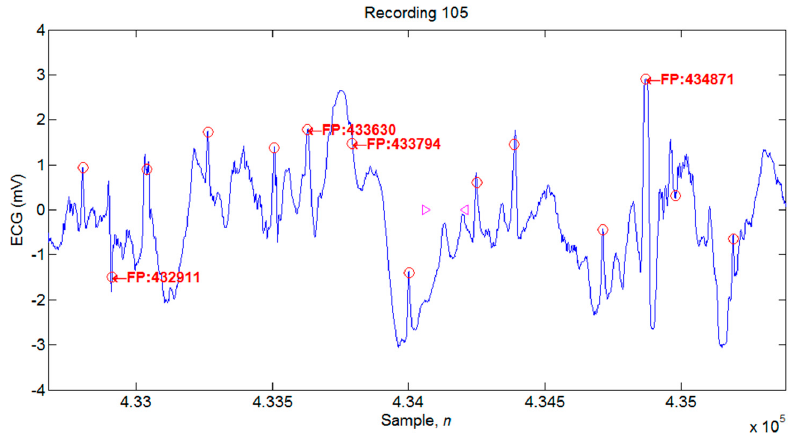
Figure 13. Illustration of the detection failures caused by greatly reduced amplitudes of QRS peaks compared to the adjacent QRS peaks.